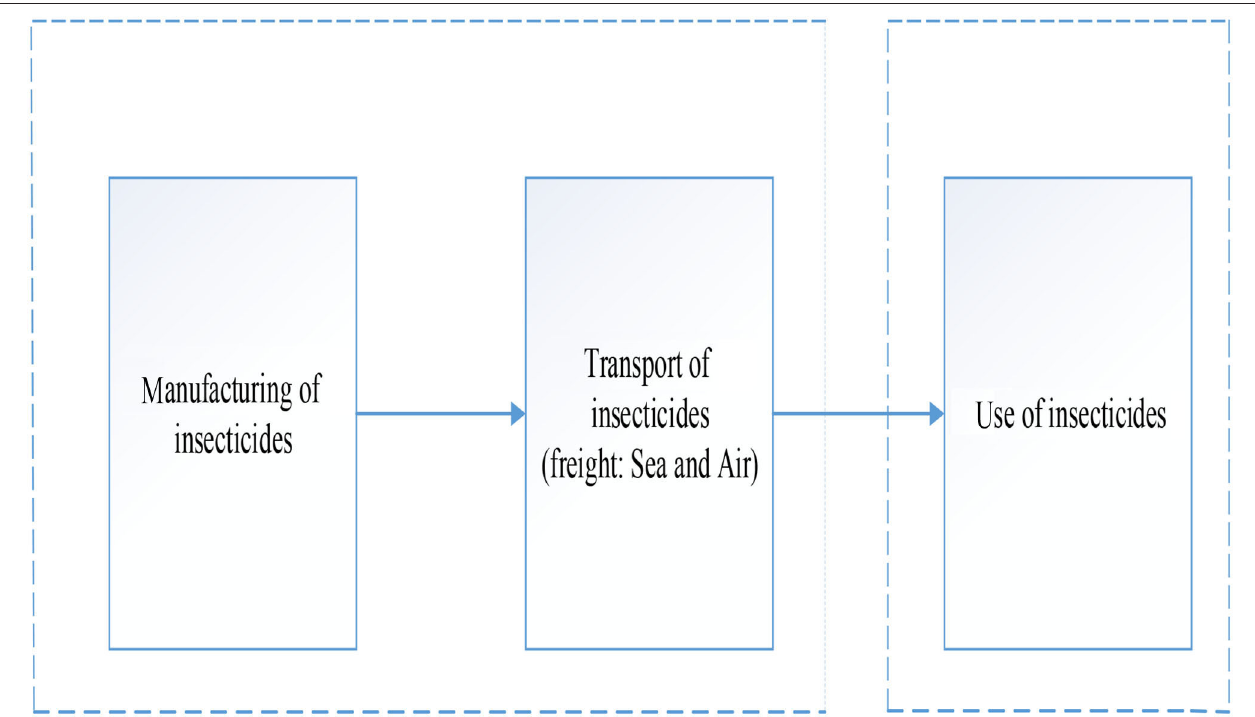
FIGURE 1 | System boundary for the environmental assessment: sustainable minds was used for the manufacturing and transport of insecticides, and TRACI was used for insecticides usage (Generated using microsoft